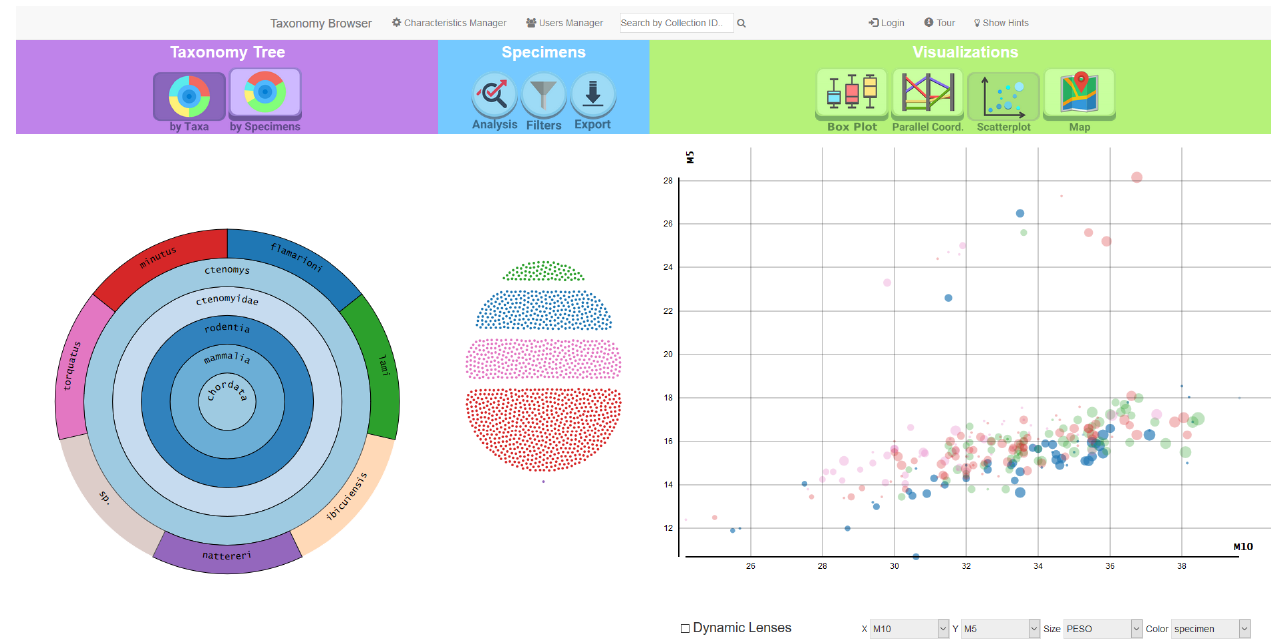
Figure 2. The interface developed for the TaxonomyBrowser. Left: Sunburst visualization showing all species represented in the database starting from the highest level ( Chordata , in this case), with species minutus , torquatus , flamarioni , lami and nattereri selected. Center: all specimens selected in the Sunburst visualization, with or without further filtering. Right: example of a visualization available for displaying data about selected specimens. Top: options for the taxonomic tree visualization, specimens manipulation, and data attributes visualizations (box plots, parallel coordinates, scatterplot, and map). Above those buttons there is a header with options for managing the characteristics and users, a search bar for finding specimens by their collection ID, a log-in button and the tour of all the features provided by the